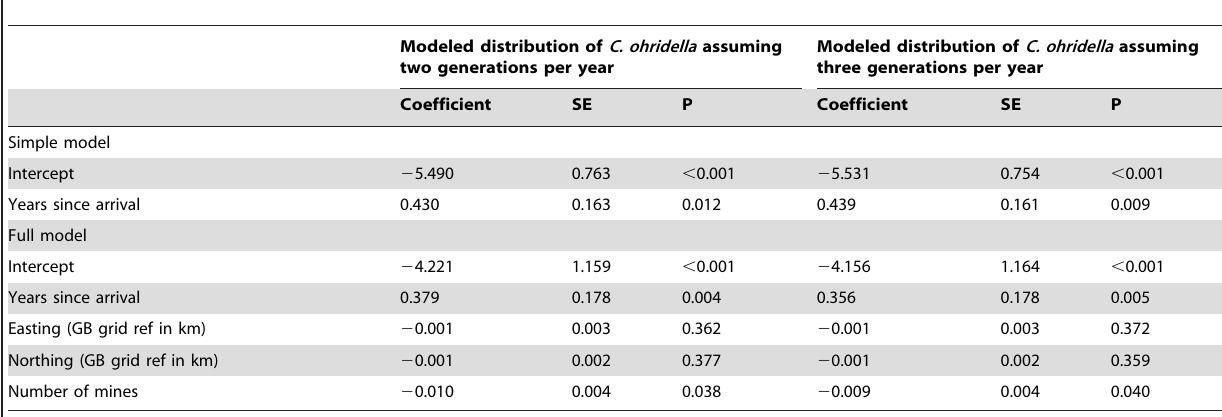
Table 4. The parameter estimates (excluding random effects) from the logistic generalized linear mixed model predicting the effect of length of time since arrival on